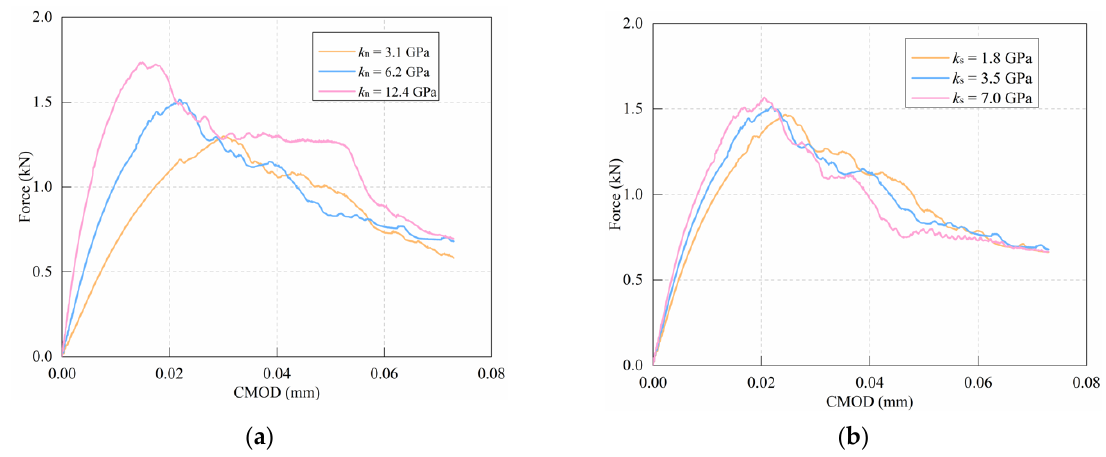
Figure 12. Experimental and simulation results of notched mortar beam.